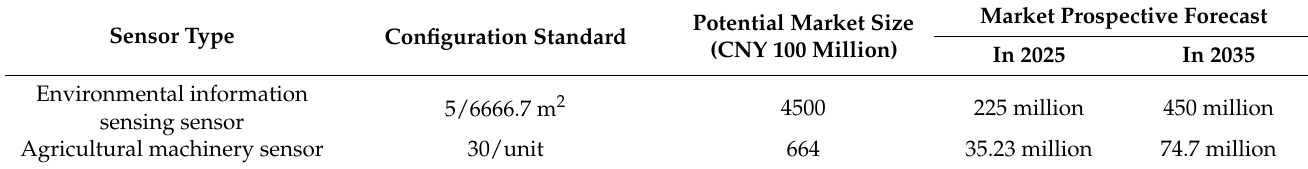
Table 5. Potential market scale and prospective forecast of field planting